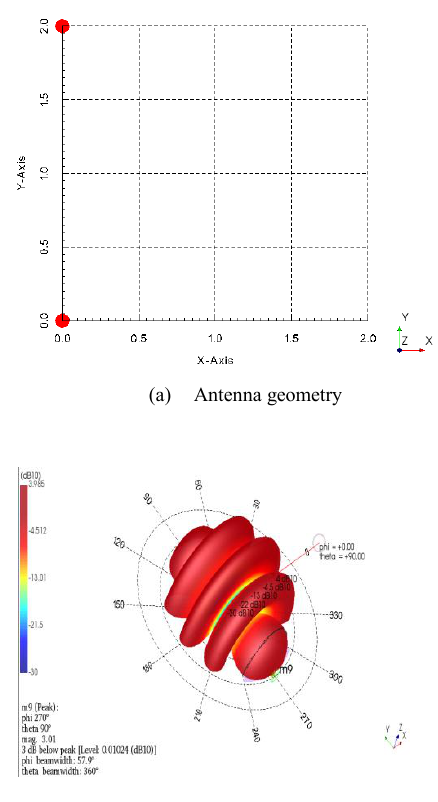
Figure 10. Linear antenna array (N=2, dy = 2λ , βy =